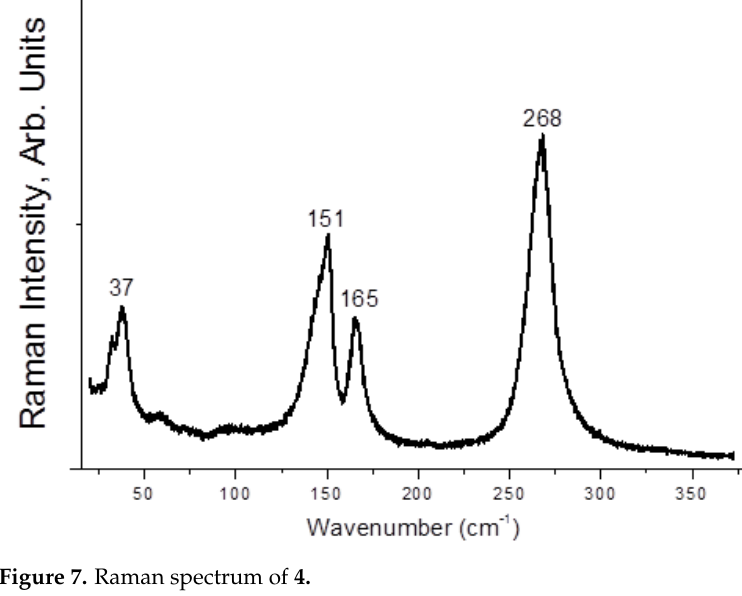
Figure 7. Raman spectrum of 4.